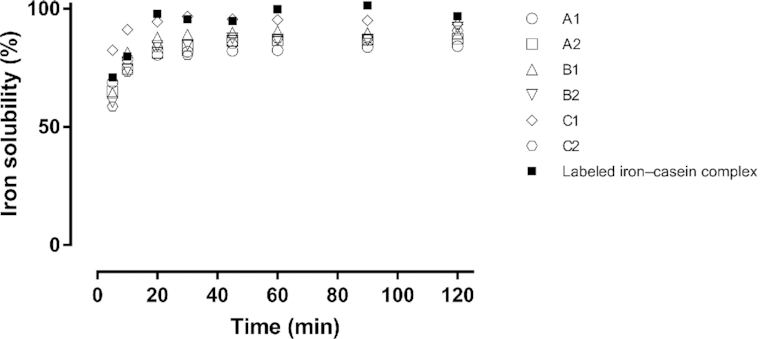
Iron solubility of unlabeled batches (A1, A2, B1, B2, C1, C2) and a labeled (57Fe) batch of iron–casein complex in 0.02 M HCl tested on day 1 (A1, B1, C1) and day 2 (A2, B2, C2). There was no statistically significant difference in iron solubility between the unlabeled and labeled iron–casein complexes (repeated-measures ANOVA F3,51 = 2.13, P = 0.11) or between days the samples were tested (F1,51 = 3.40, P = 0.07).